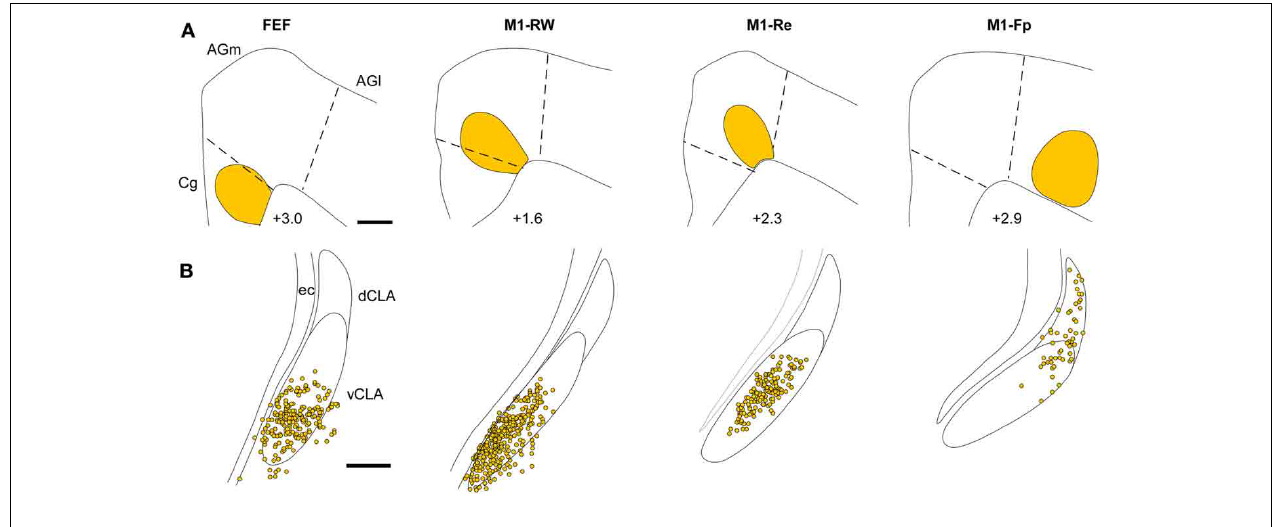
FIGURE 7 | Representative examples illustrating the topography of labeled neurons in the claustrum produced by tracer injections in FEF, M1-RW, M1-Re, and M1-Fp. (A) Reconstructions of the M1 tracer injections in the current study (case TI-15) and in